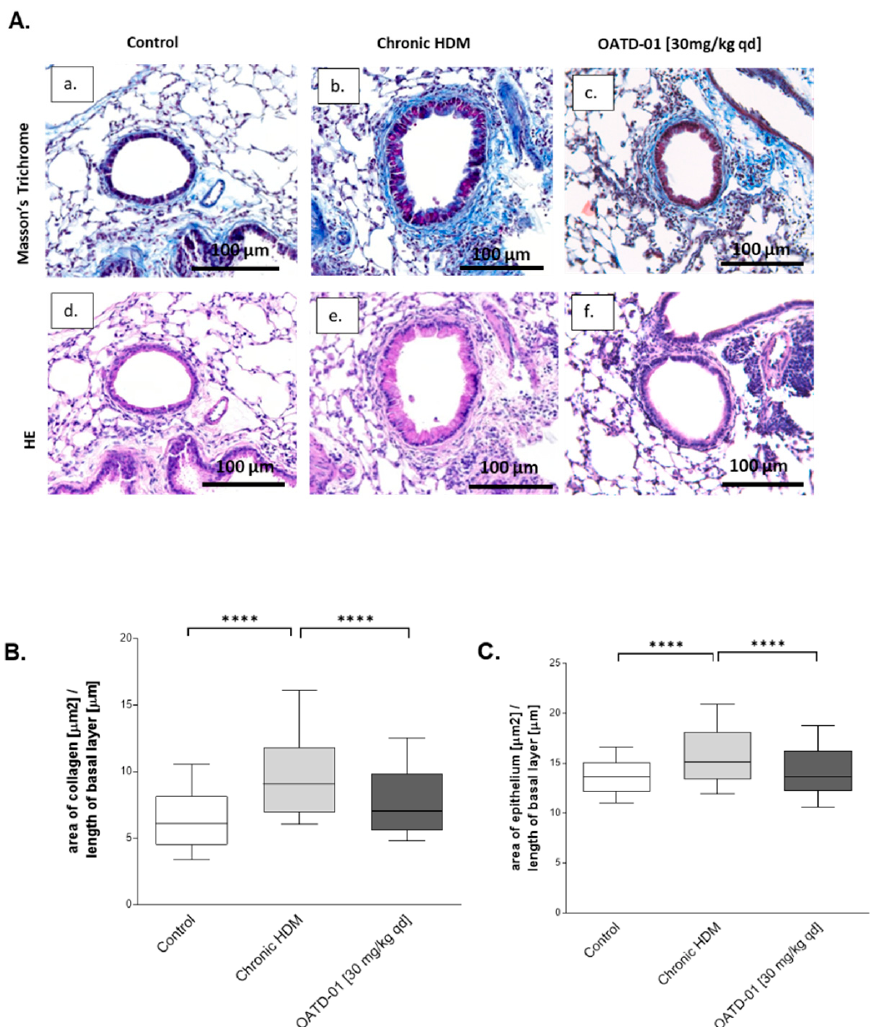
Figure 6. OATD-01 reduces features of airway remodeling after chronic HDM administration. ( A ) Histological evaluation of airway remodeling (bronchiole collagen wall and epithelial thickness) as represented by Masson’s trichrome ( a – c ) and hematoxylin and eosin ( d – f ) in a 7-week-long chronic HDM model in C57BL/6 mice treated with OATD-01 (30 mg/kg; PO; qd) ( c , f ) or vehicle control; Control ( a , d ) and Chronic HDM ( b , e ). ( B ) Quantitative analysis of peribronchial collagen area (collagen wall thickness) stained with Masson’s trichrome in a chronic HDM model with or without OATD-01 treatment (30 mg/kg; PO; qd; n = 8). ( C ) Quantitative analysis of bronchiole epithelial thickness, measured at the same time as analysis of collagen wall thickness (on Masson’s trichrome-stained samples) in a HDM model with or without OATD-01 treatment (30 mg/kg; PO; qd; n = 8). Data presented as mean ± s.e.m. p -values < 0.05 were considered as statistically significant and presented as **** for p < 0.0001.